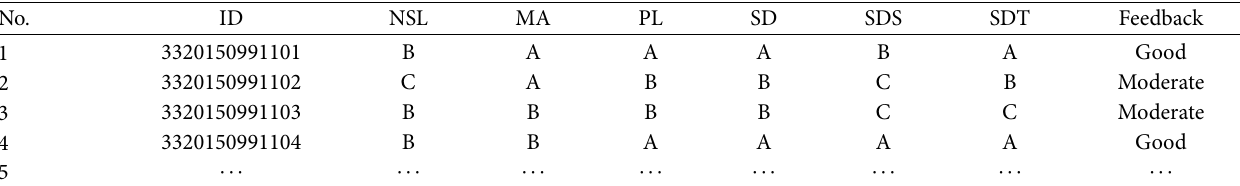
Table 3: Graduate data